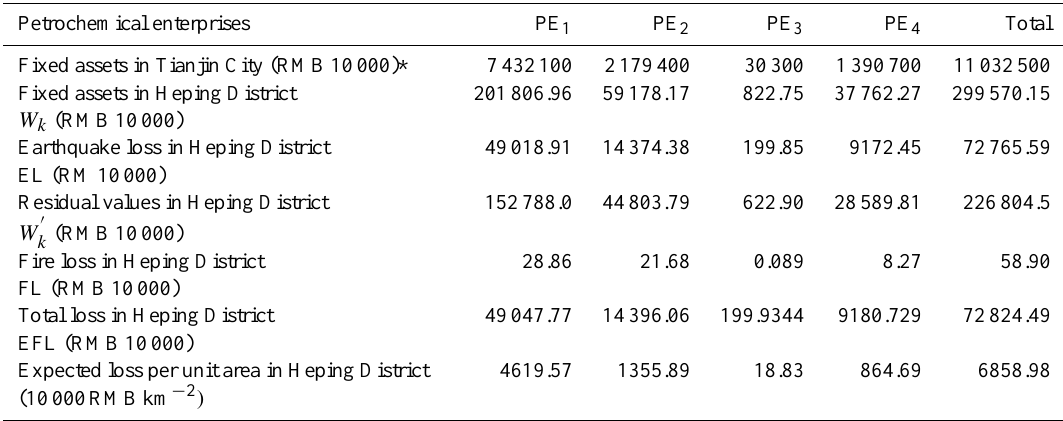
Table 5. Expected loss of earthquake-fire for the petrochemical enterprises in Heping District of Tianjin